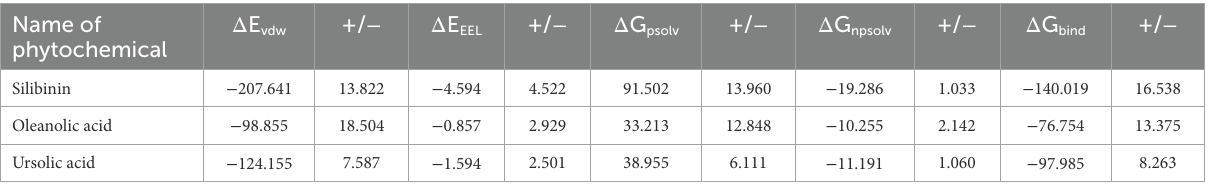
TABLE 3 Summary of energy components from MM/PBSA analysis of the lead phytomolecules with the A26 protein. Name of phytochemical